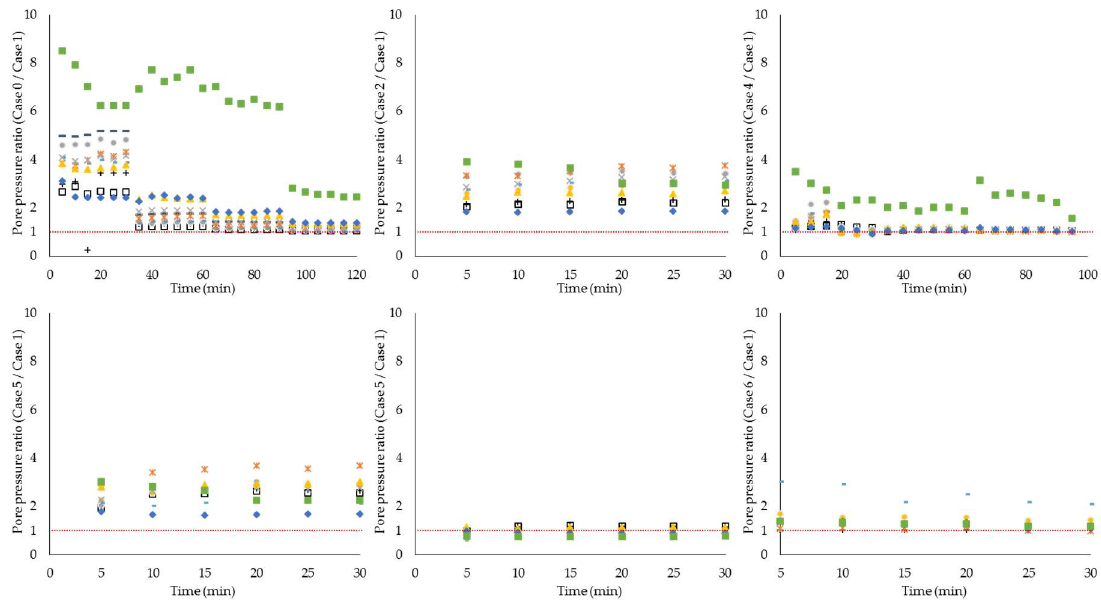
Figure 8. The relationship between the pore water pressure ratio in each case. Red break line means that the pressure ratio is 1. The pore water pressure of Case 2 was higher than Case 1, generally. The pore water pressure of Case 4 was also higher than Case 1, generally. This result implies that the influence of the confluence of pipe and entrapped air on the buildup of pore water pressure.